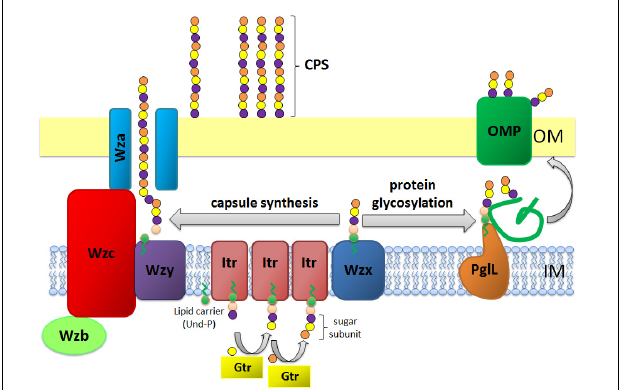
FIGURE 1 | Schematic representation of capsule polysaccharide assembly and export in A. baumannii . Synthesis begins with the initial transferase (Itr; maroon) located in the inner membrane (IM) transferring the first sugar of the repeating unit to a lipid carrier (Und-P; green circle). Subsequent sugars are then added to the growing unit by specific glycosyltransferases (Gtr; yellow) on the cytosolic side of the inner membrane. The capsule subunit (K unit) is then transferred to the periplasm via the integral membrane protein Wzx (dark blue). The sugar subunits are polymerized by the Wzy protein (purple) and the Wza/Wzb/Wzc complex (cyan, lime, red) coordinates high level polymerization and export of the growing chain, moving them to the outer membrane (OM). For glycosylation, PglL (orange) links the K units onto selected outer membrane proteins (OMP; dark green).